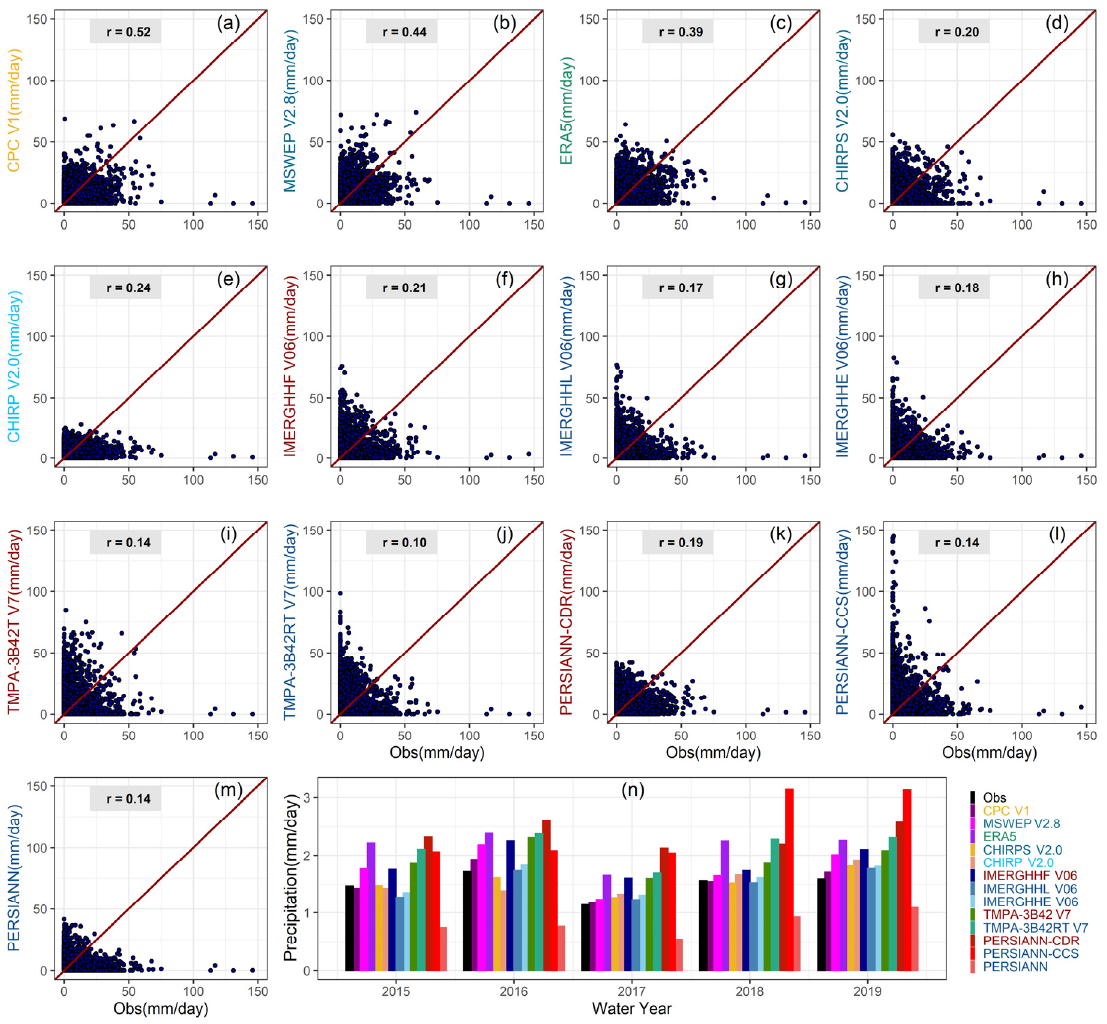
Figure 4. Scatter plot of daily gauge precipitation measurement versus GPDs for the entire period; ( a ) CPCv1; ( b ) MSWEPv2.8; ( c ) ERA5; ( d ) CHIRPSv2.0; ( e ) CHIRPv2.0; ( f ) IMERGHHFv0.6; ( g ) IMERGHHLv0.6; ( h ) IMERGHHEv0.6; ( i ) TMPA-3B42v7; ( j ) TMPA-3B42RTv7; ( k ) PERSIANN-CDR; ( l ) PERSIANN-CCS; ( m ) PERSIANN; and ( n ) Mean annual daily precipitation. Y axis color; satellite (blue), gauge and satellite (red), reanalysis and satellite (sky blue), reanalysis (green), reanalysis, ground, and satellite (steel blue), and ground (yellow).